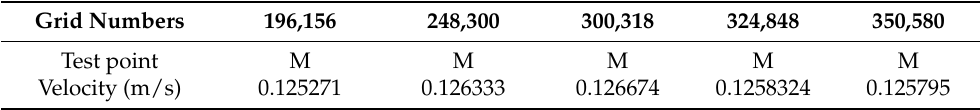
Table 4. Analysis result of velocity for different grid numbers.